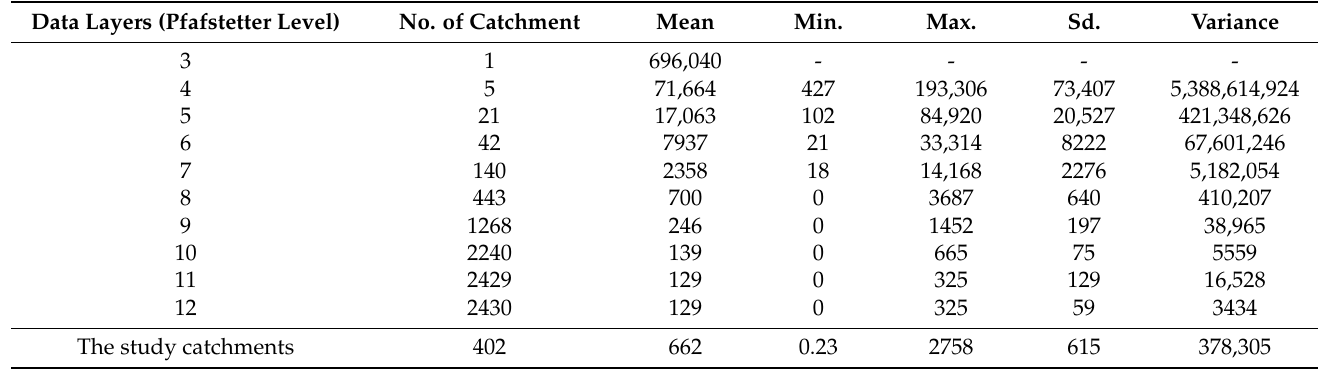
Table 1. Area (km 2 ) statistics for the study catchments in Poland [38]. Data Layers (Pfafstetter Level) No. of